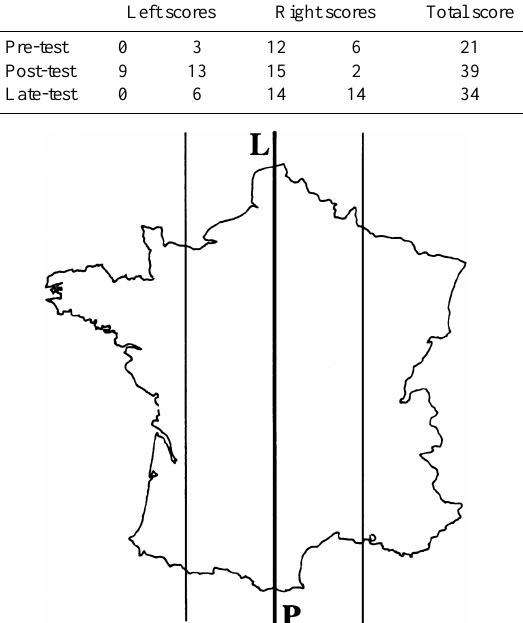
Fig. 3. Drawings of a daisy, from memory, in three conditions: prior to prism exposure (Pre-test), immediately after removing the goggles (Post-test), and after a delay of about 24 hours following the prism exposure (Late-test). 23 for the right and 21.5 for the left). Morever the comparison of the difference between the right and left scores showed no difference prior to prism exposure ( − 2 . 5) and after (1.5). For the 2 control-subjects, the mental evocation of the map of France thus was not modified by the prism adaptation.